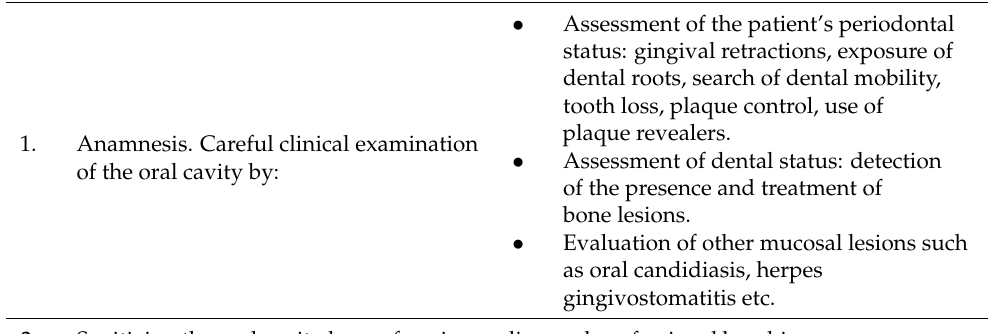
Table 4. Management of desquamative gingivitis patient in the dental